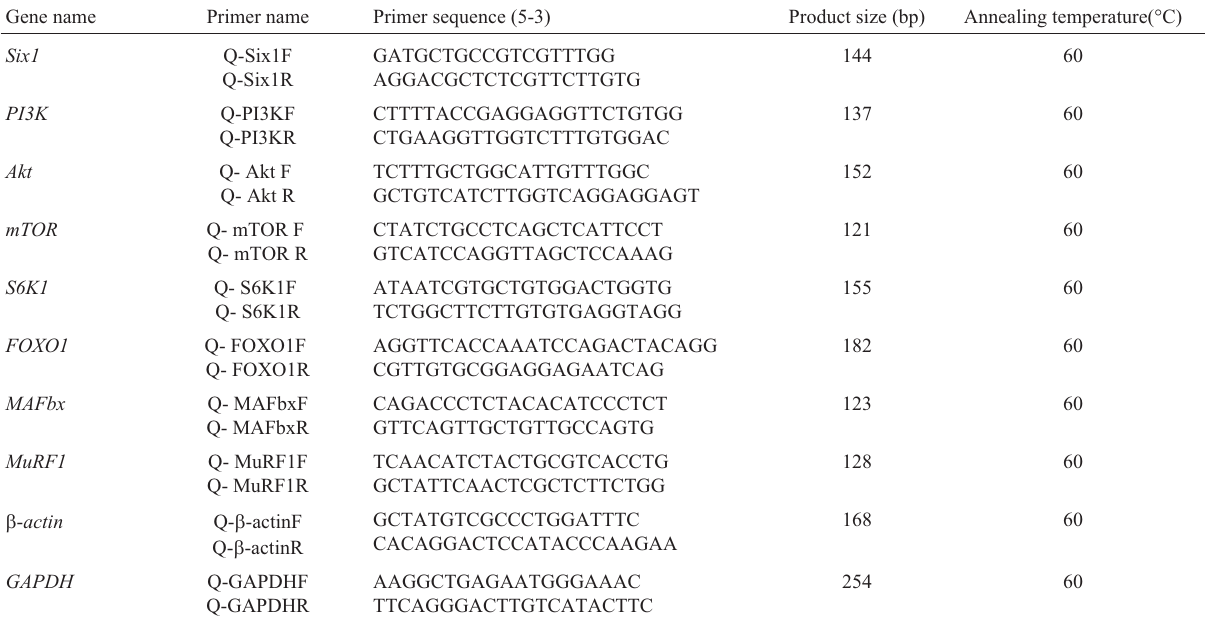
Table 1 - Primers used for quantitative real-time PCR used in this